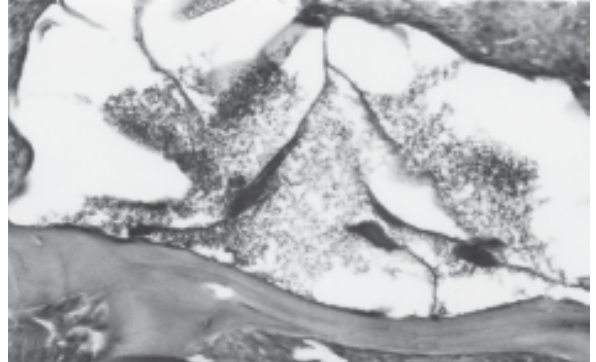
FIGURE 8 - BG, 60 days. Detail of granule excavation (A) showing newly formed bone (B) and reticular aspect of the material. HE. Magnification